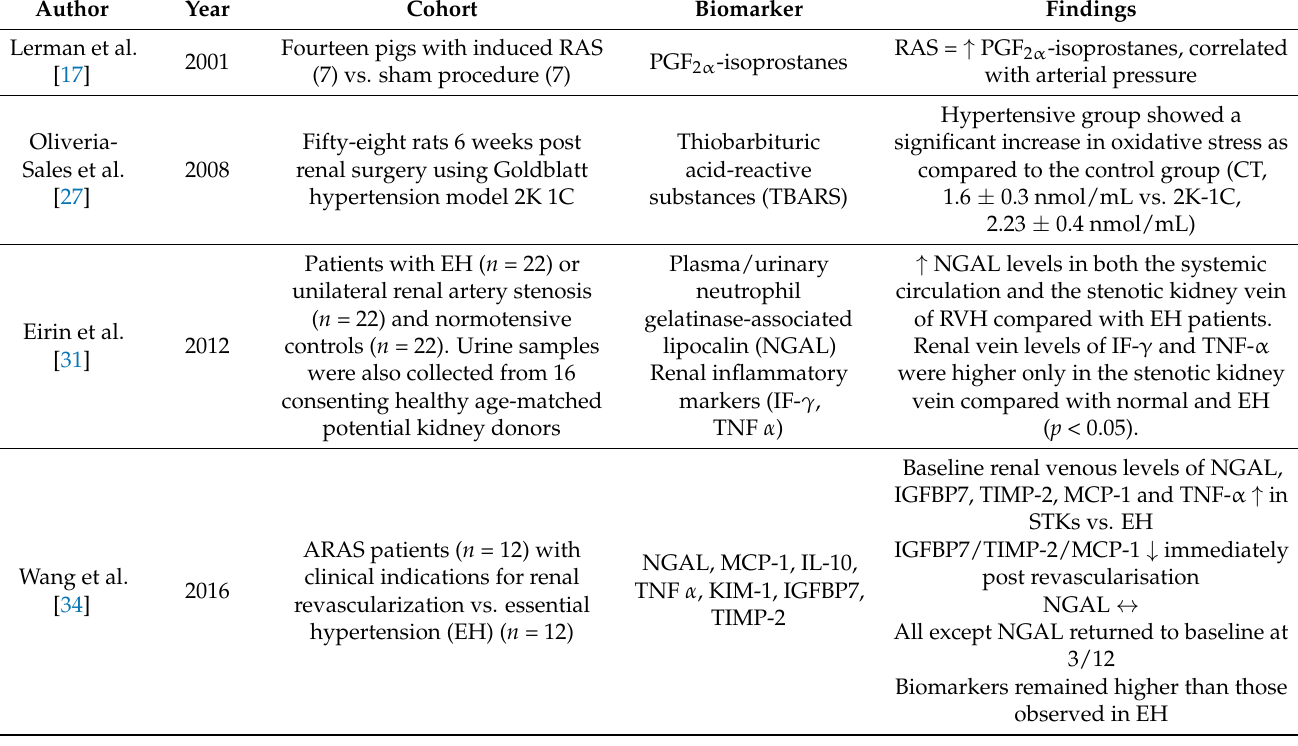
Table 2. Trials of biomarkers for oxidative